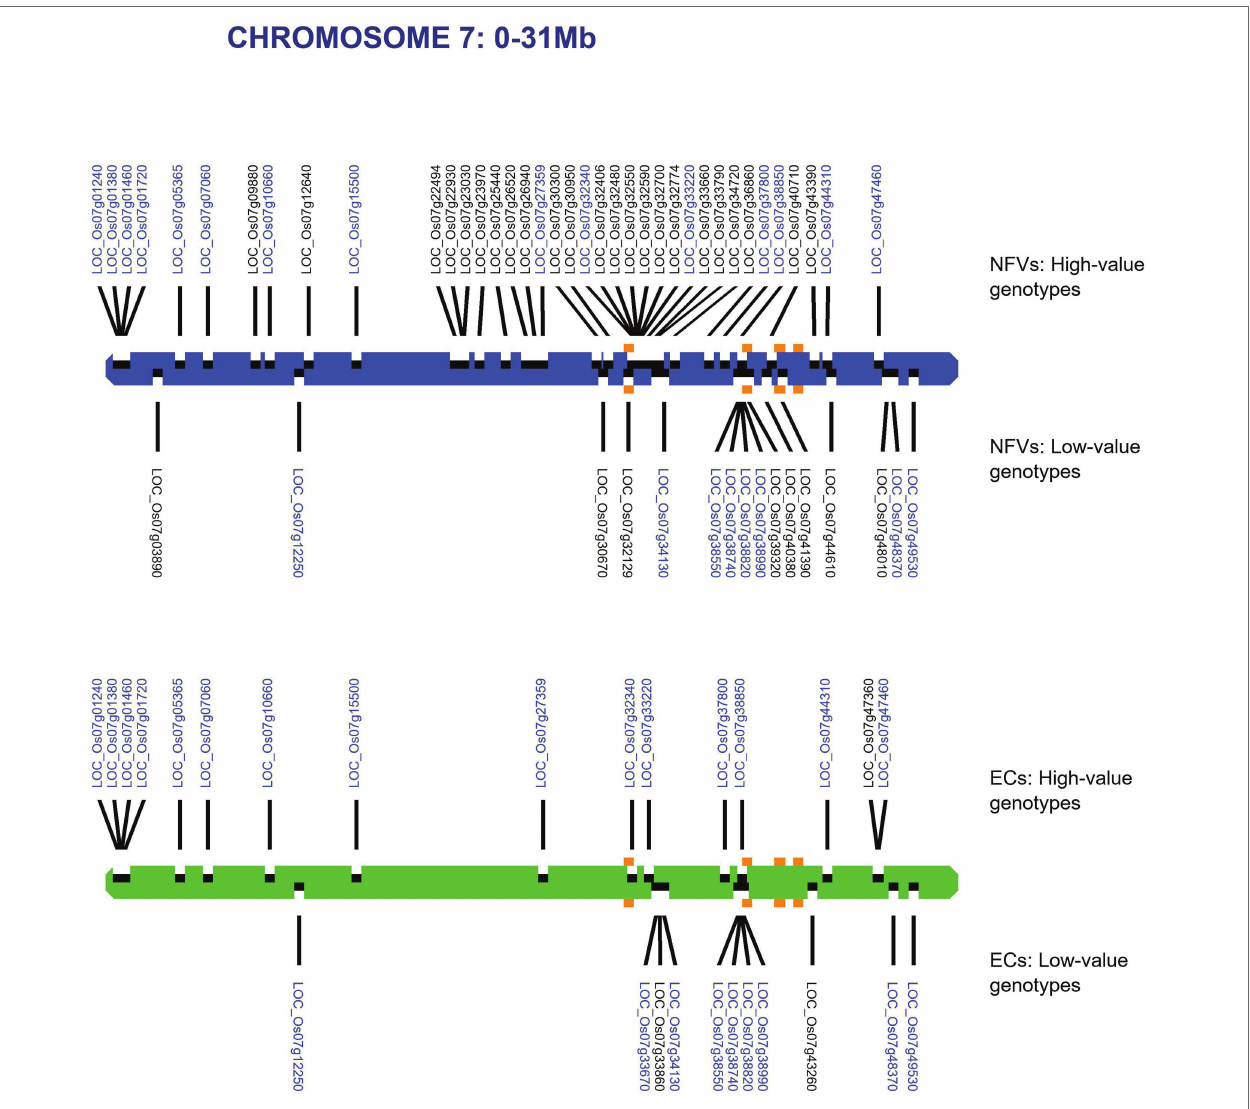
FIGURE 3 | Map of chromosome 7 showing identified haplotypes associated with large and small grain sizes identified in a global database found across our TRR panel. RD varieties and landraces (NFVs)—blue chromosome; RGD targeted breeding accessions (ECs) – green chromosome. Haplotypes associated with large grain size are indicated above each chromosome whilst haplotypes associated with small grain size are indicated below. The known grain size gene positions for LOC_Os07g32170 , LOC_Os07g39220 , LOC_Os07g41200* , LOC_Os07g41240* and LOC_Os07g42410 are indicated with orange squares (* adjacent genes identified by the same square). Gene annotation names in blue text are found among both NFV and EC